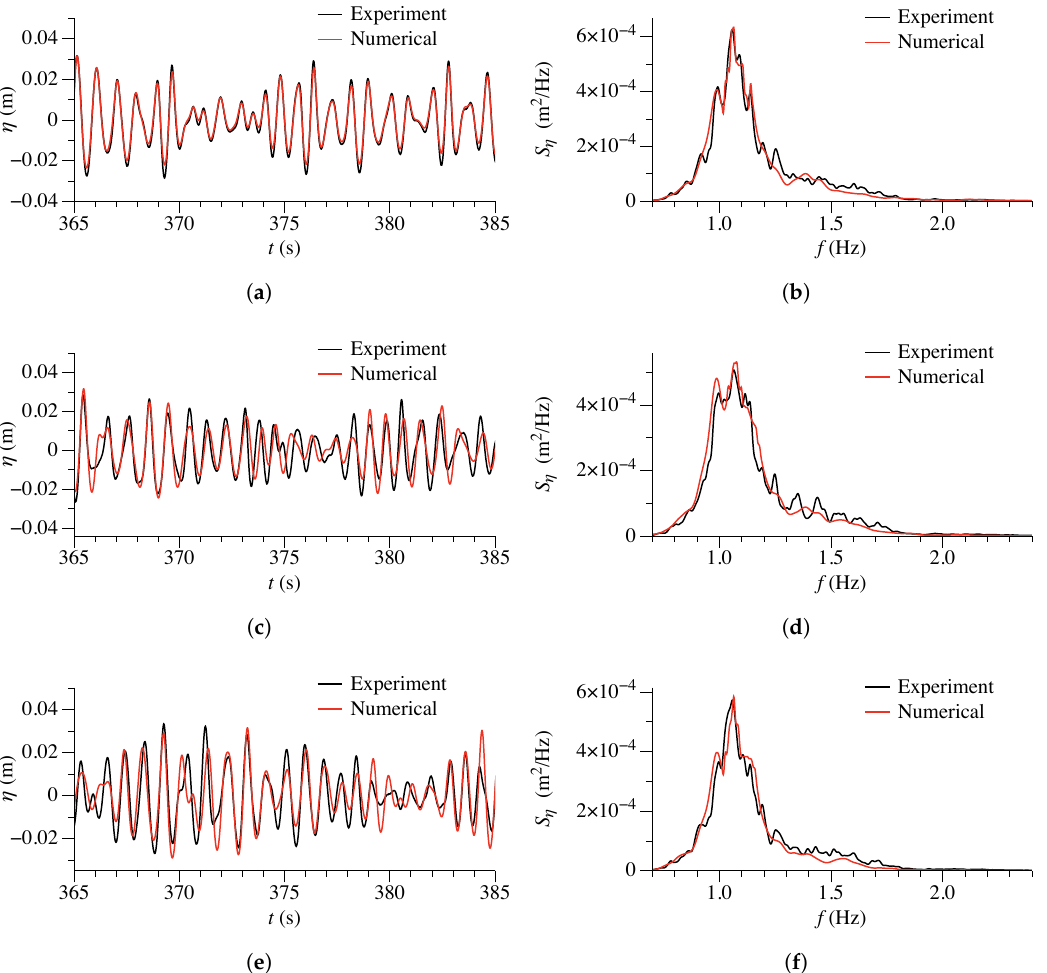
Figure 15. Comparison of the numerically reconstructed and experimental irregular wave signal in time and frequency domains for irregular waves impacting the cylinder at ( a ) W1 (time-domain); ( b ) W1 (frequency-domain); ( c ) W2 (time-domain); ( d ) W2 (frequency-domain); ( e ) W3 (time-domain); ( f ) W3